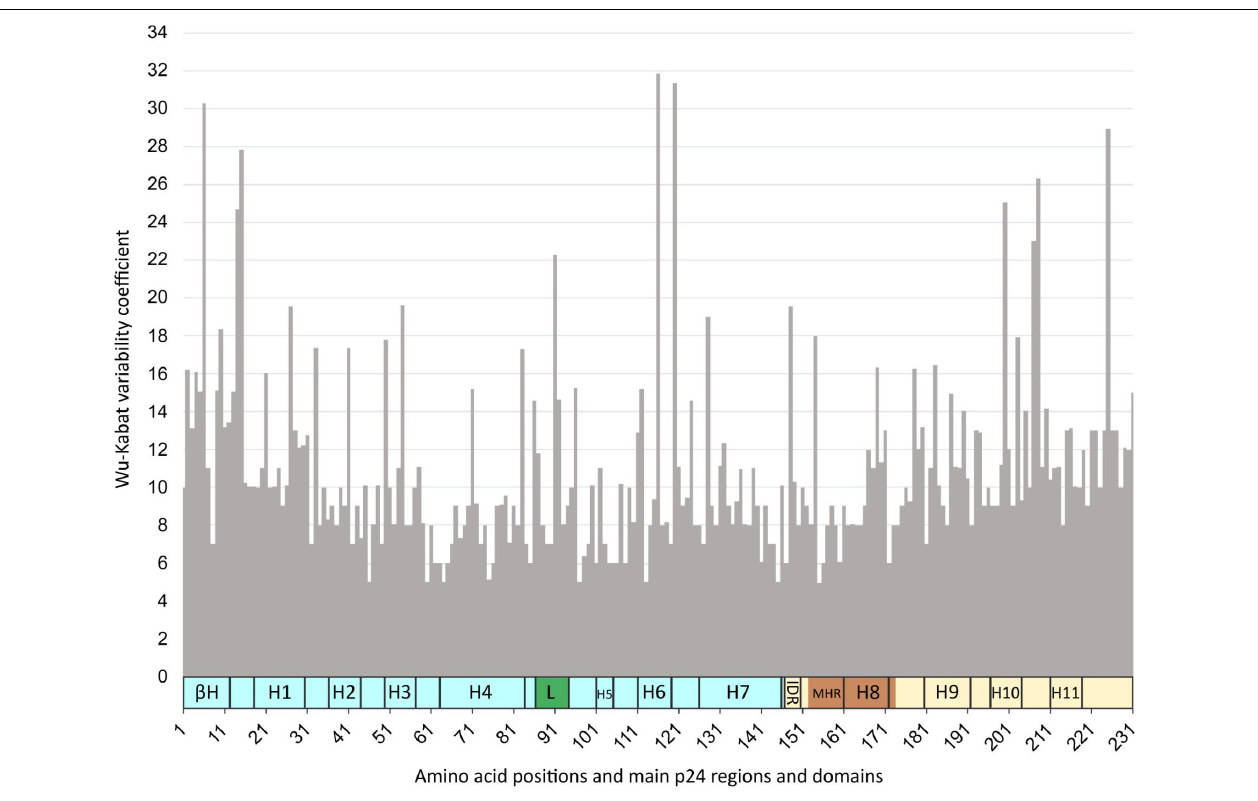
FIGURE 6 | Wu–Kabat (WK) p24 variability coefficient plot in HIV-1 group M sequences. X -axis, amino acid positions and main p24 regions and domains; Y -axis, Wu–Kabat variability coefficient. β H, β -hairpin; H, α -helix; L, Cyp A-binding loop (green); IDR, interdomain linker region; MHR, major homology region (dark orange); in light blue, N-terminal domain; in light yellow, C-terminal